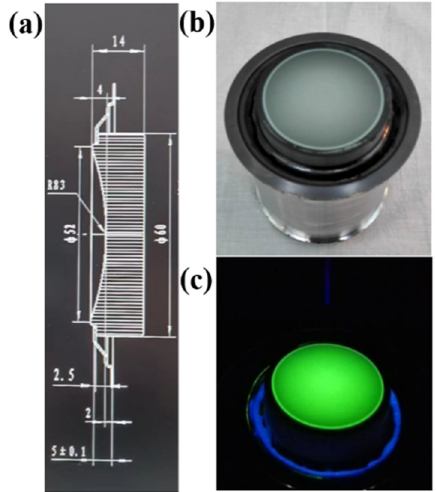
Figure 2. R83 mm spherical fluorescent screen: ( a ) structure diagram; ( b ) fluorescent screen assembly drawing; ( c ) luminous condition of fluorescent screen.